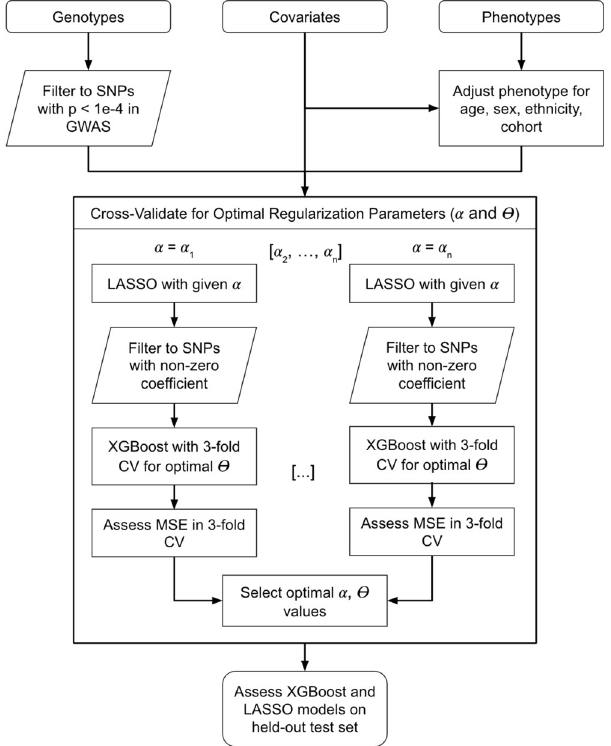
Fig. 2 Flow chart of ensemble model structure. The model relies on jointly training the LASSO and XGBoost model to identify the optimal value for the L1 regularization parameter and the number of boosting steps. CV indicates cross-validation, α refers to the regularization parameter, and Ɵ is the number of boosted trees for XGBoost. The optimal values for these hyperparameters were selected using threefold CV for the mean squared error of the XGBoost Alone model, with relative PVE increase of 20 – 175%. For XGBoost with PRS, the increase from LASSO is more attenuated, at only 7 – 21% higher than random selection. In Supplementary Table 7, we report results from using SNPs selected into lassosum2 PRS for LDL cholesterol. The test EVR for the XGBoost model with the lassosum2-selected SNPs was 9.0% compared to 13.3% when using the LASSO SNP selection model.